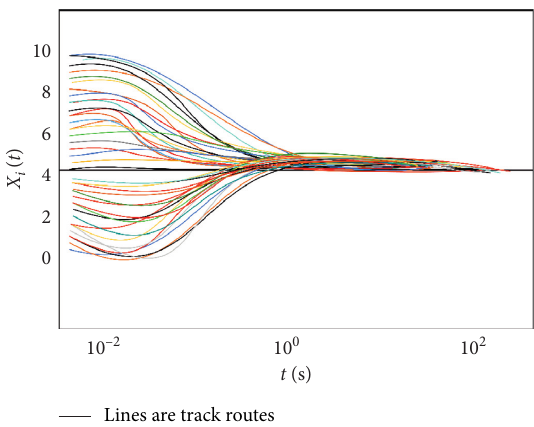
Figure 7: Data diagram after using tractor between different